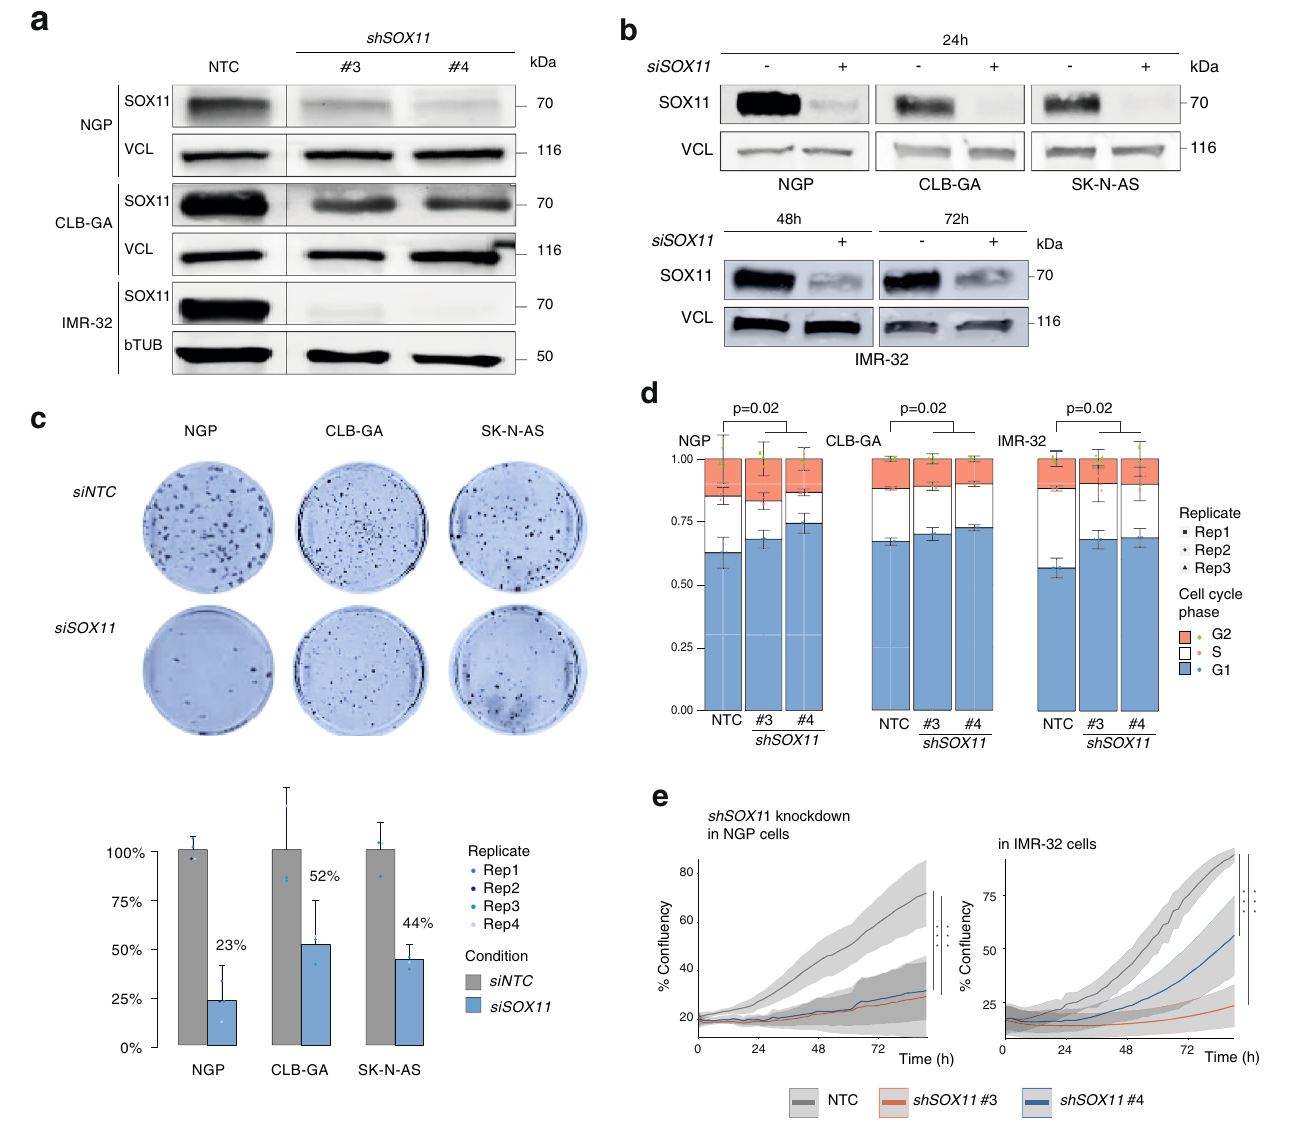
Fig. 3 | SOX11 is a dependency factor in adrenergic NB cells. a SOX11 protein levels 6 days upon shSOX11 treatment in NGP, CLB-GA and IMR-32 cells with 2 different shRNAs and one non-targeting control (NTC). Vinculin (VCL) and β - tubulin(bTUB)wereusedasloadingcontrol.NTCandshRNAsampleswererunon the same blot. Blots for NGP and CLB-GA have been repeated three time with similarresults.BlotforIMR-32hasbeenrepeatedonce. b SOX11proteinlevels24h uponsiRNAtreatmentinNGP,CLB-GAandSK-N-AScells(dharmafecttransfection). SOX11 protein levels 48h and 72h upon si SOX11 treatment in IMR-32 (nucleofec- tion). Vinculin (VCL) is used as loading control. Blot for IMR-32 for 48h has been repeatedfourtimeswithsimilarresults,restonce. c Reductionincolonyformation capacity for NGP, CLB-GA and SK-N-AS cells, 14 days upon siRNA SOX11 treatment (dharmafecttransfection)ascomparedtonon-targetingcontrol(siNTC).Datawere generated in triplicate for eachcellline,and quanti fi cation was done using ImageJ.